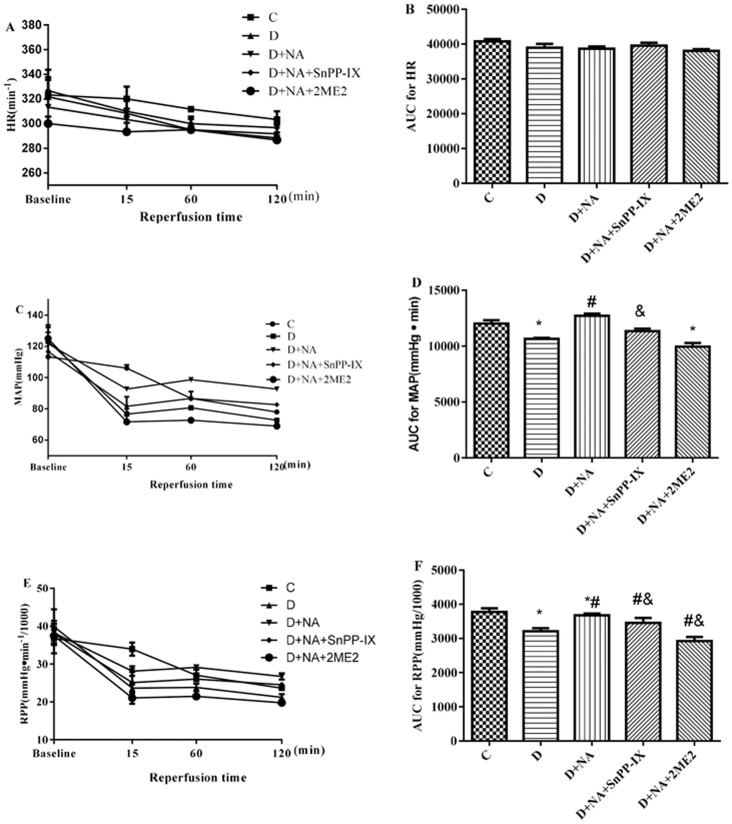
Hemodynamic changes measured at baseline (10 minutes before ischemia), at 15 minutes of ischemia, at 60 minutes of reperfusion, and at 120 minutes of reperfusion in diabetic rats with or without antioxidant treatment.Heart rate (HR), mean arterial pressure (MAP) and rate pressure product (RPP) were measured at baseline and during ischemia and their area under the curves (AUC) are shown. C and D indicate control or diabetes, respectively. D+NA, D+ NA+ SnPP-IX, D+NA+2ME2 indicates diabetic rats, treated with NAC+ALP (NA) or NA+SnPP-IX or NA +2ME2, respectively. All values are expressed as means ± S.E.M. (n = 7). *P<0.05or P<0.01 vs. their corresponding baseline; #P<0.05 or P<0.01 vs. their corresponding D groups; &P<0.05 or P<0.01 vs. their corresponding D+NA groups.